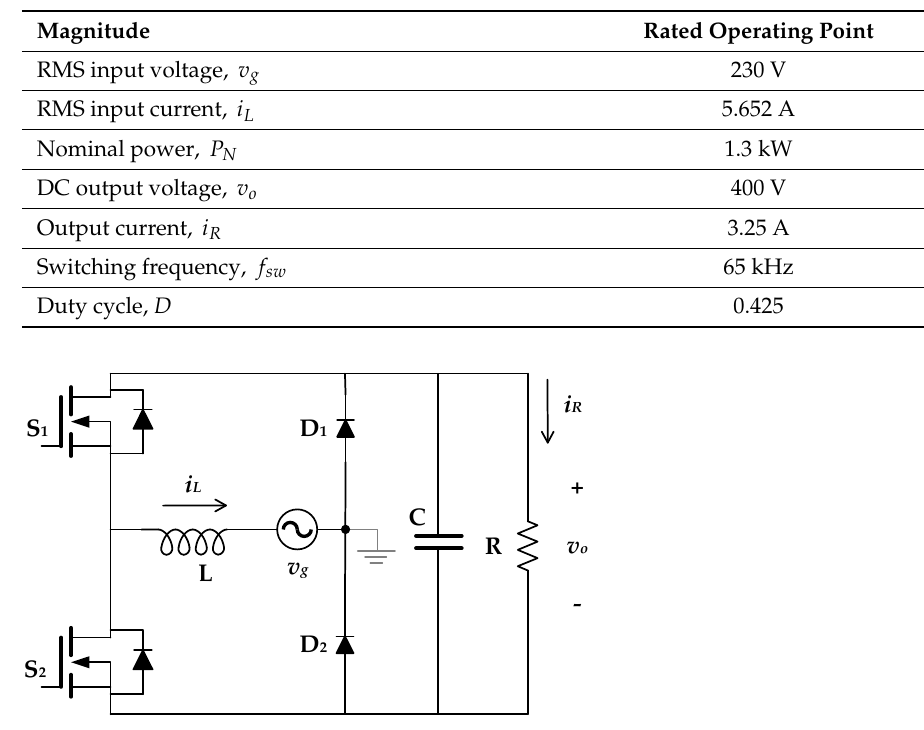
Figure 2. Schematic of the totem-pole converter.